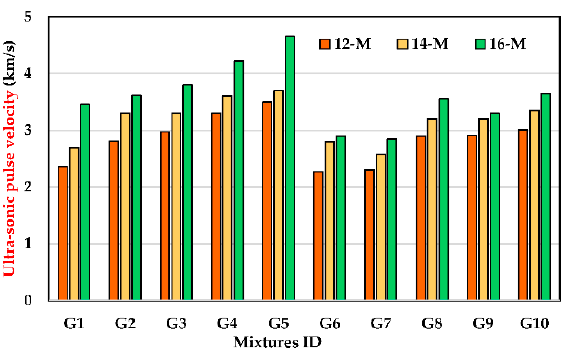
Figure 8. Effect of KOH molarity and ASM type on ultrasonic pulse velocity of the UHPGC at curing heat 60 °C.